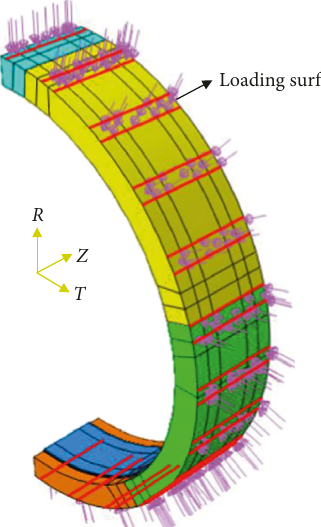
Figure 7: Loading demonstration in finite element